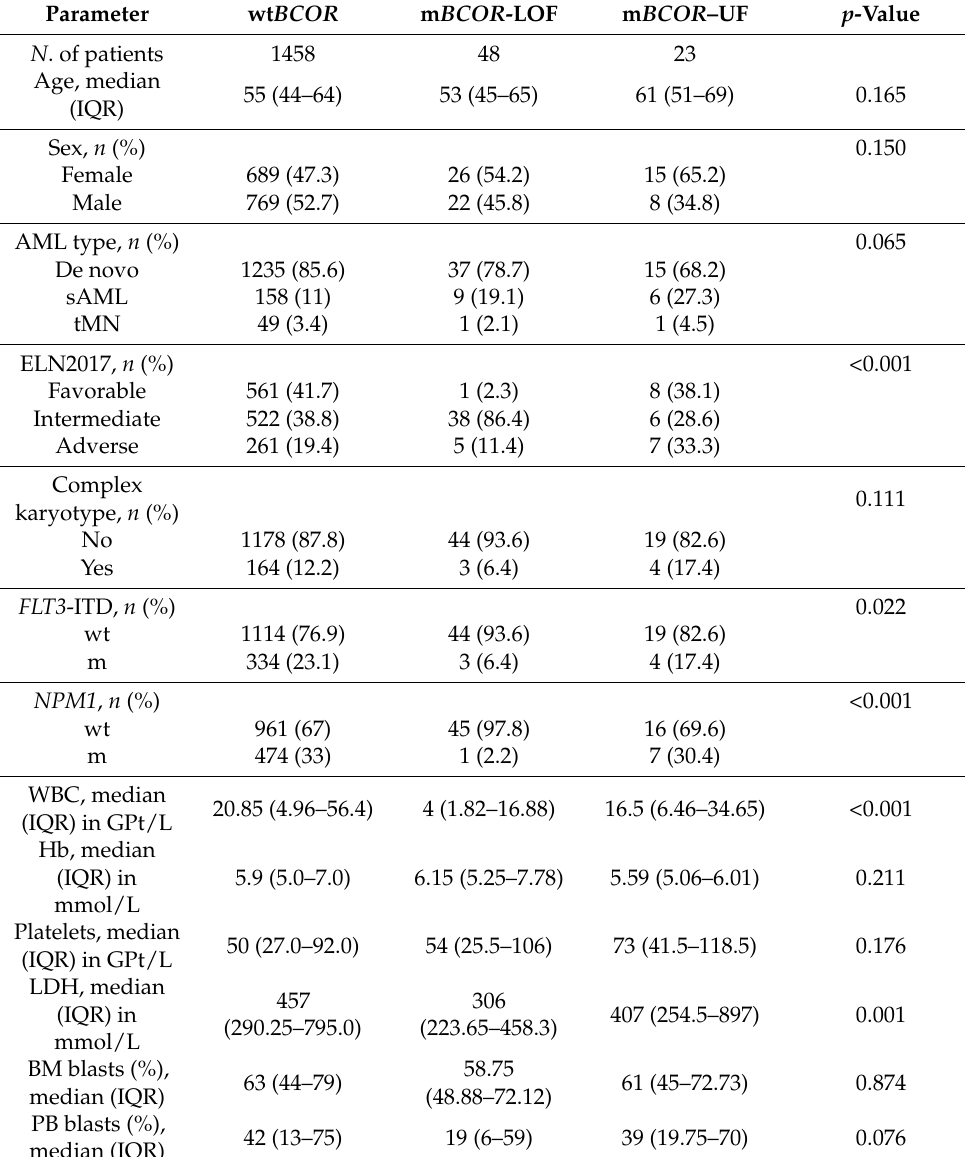
Table 1. Patient characteristics for m